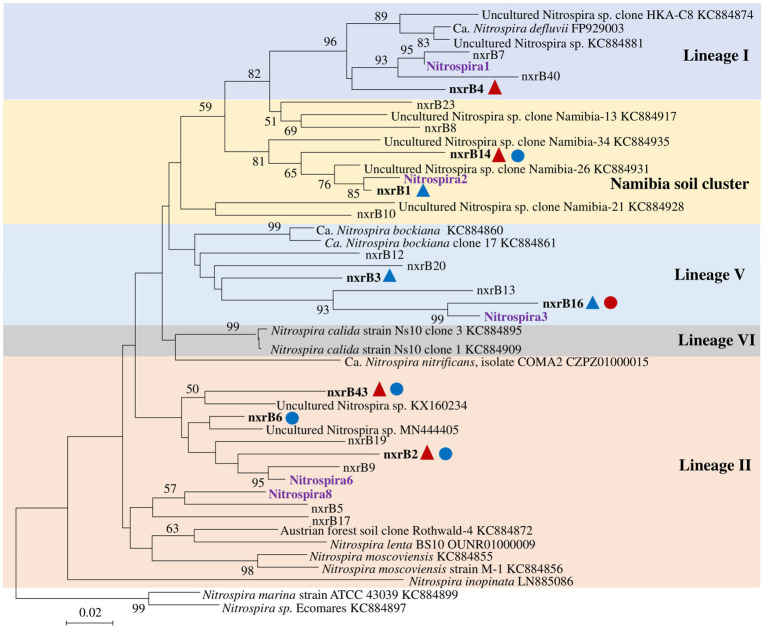
Neighbor joining tree for Nitrospira partial nxrB top 20 OTUs (covered 94.9% of total sequences). The scale bar represents 1% nucleic acid sequence divergence, and bootstrap values (>50%) are showed at branch points. OTUs are shown in bold if they were significantly changed by N treatment. Up triangles indicate a significant difference between values for control and AS treatments, while circles indicate a significant difference between values of control and compost treatments. Red color indicates a significant higher abundance than control treatment, while blue color indicates a lower abundance.